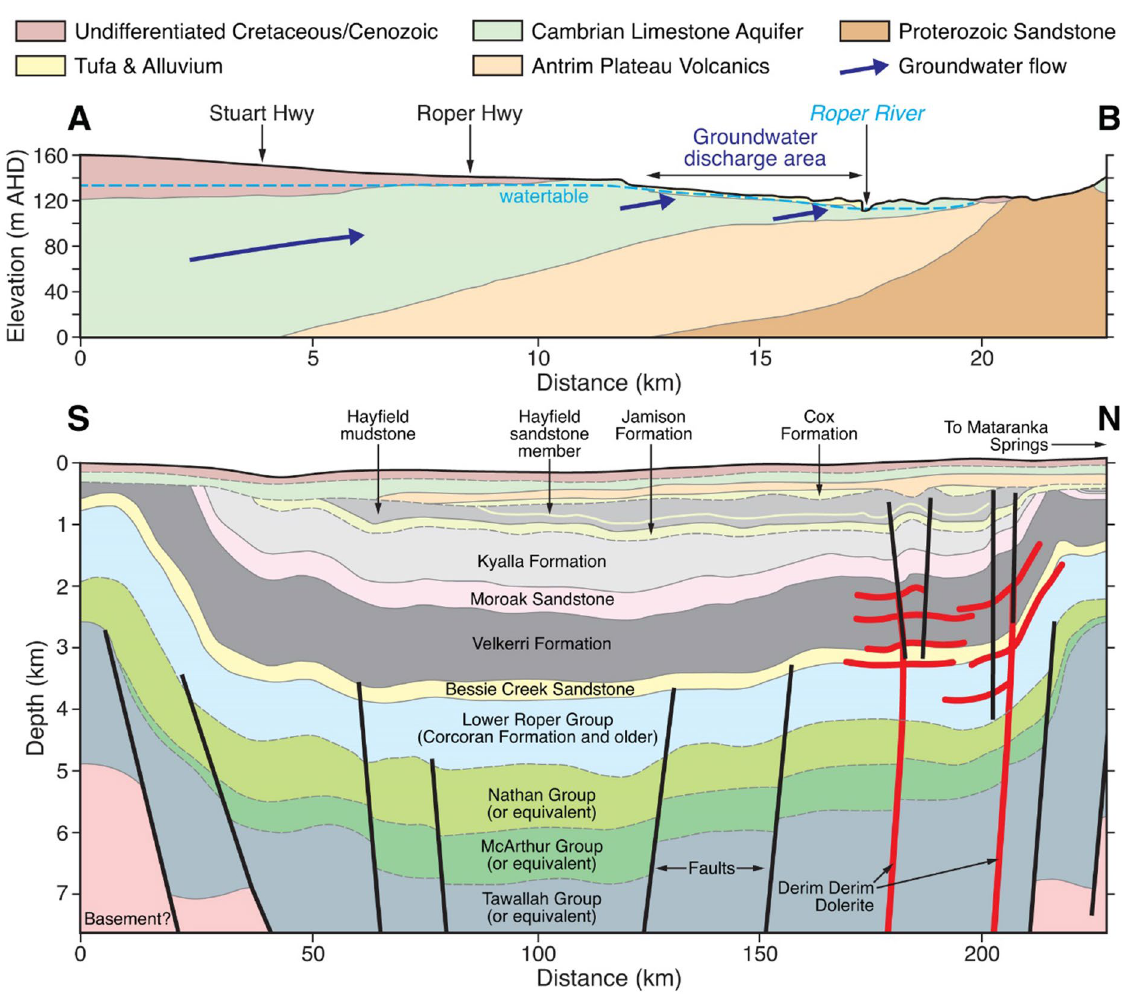
Figure 2. Geological cross-section of the Daly Basin near the Mataranka Springs Complex (top) (A–B transect in Fig. 1; modified from Tickell 8 ) and conceptualised geological cross-section for the Beetaloo Sub-basin of the Georgina Basin (bottom; modified from Orr et al. 9 ). Note the large difference in the vertical scales between the top (m Australian Height Datum) and lower cross-sections (km below ground level). The Cenozoic/Cretaceous, CLA, and Antrim Plateau Volcanics geological units (the three topmost units in the lower cross-section) are continuous from the Georgina Basin to the Daly Basin. The Proterozoic Sandstone and Siltstone of the Daly Basin (top cross-section) may be equivalent to the Bessie Creek Sandstone in the Georgina Basin (bottom